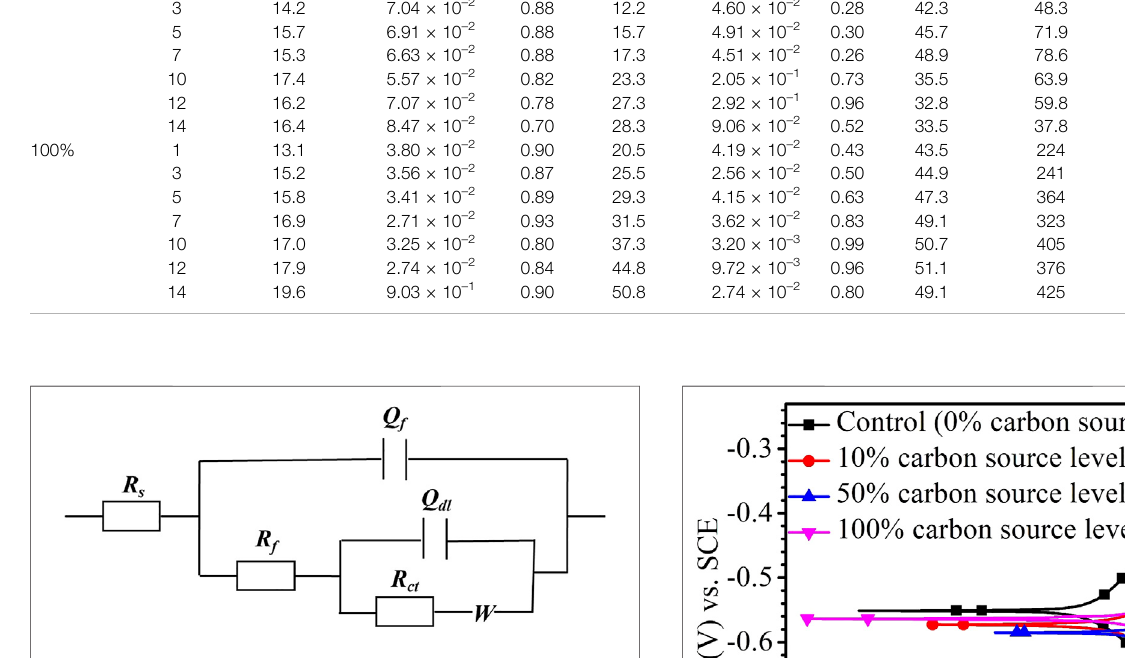
FIGURE 8 | Equivalent electrical circuit model for fi tting EIS data in Figure 7 .